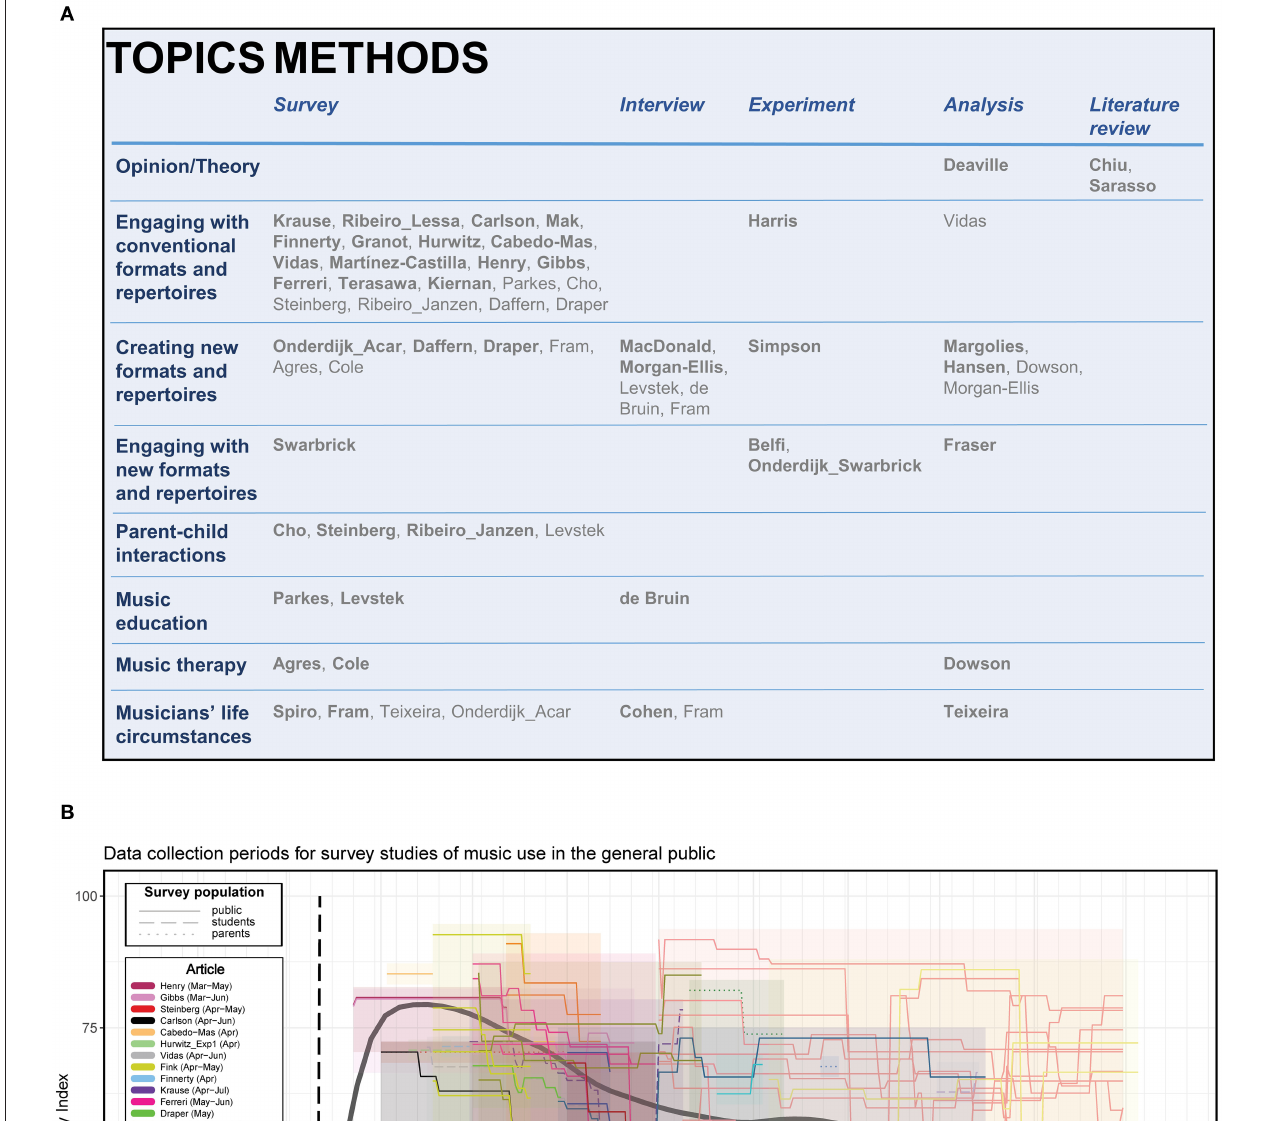
Frontiers in Psychology |